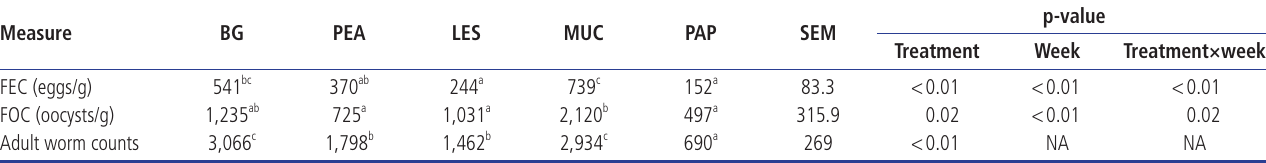
Table 6. Effects of supplementing bahiagrass (BG) hay with perennial peanut (PEA), lespedeza (LES) hay, mucuna (MUC), or papaya seeds (PAP) on gastrointestinal (GIN) fecal egg count (FEC), coccidian fecal oocysts count (FOC) and abomasal adult worm counts